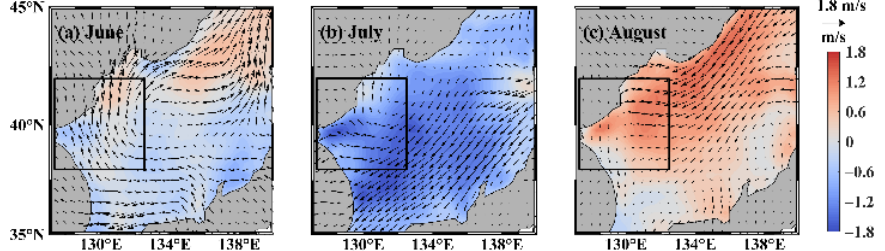
Figure 9. ( a – c ) 10-m wind speed anomaly (unit: m/s, vectors are the wind direction and the background color is the wind magnitude), from June to August 2021, relative to the climatology (1982–2021). The black box is the study area.